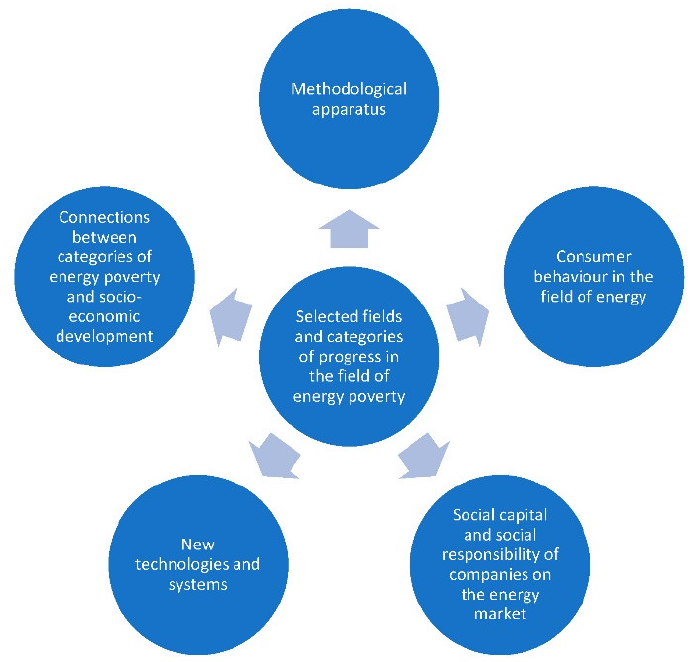
Figure 1. Selected spheres and categories of progress in the field of energy poverty.